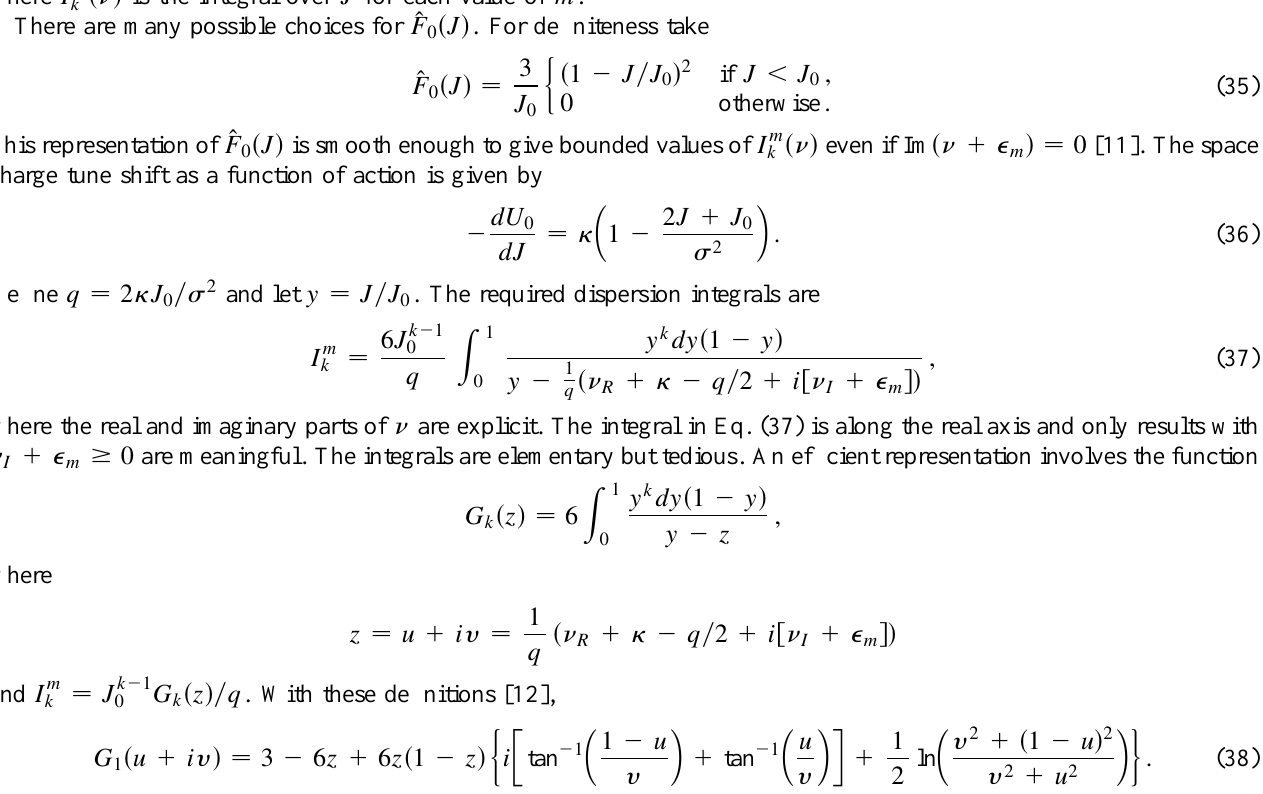
In Fig. 3, distributions from the series p p p (cid:1) 2 s 2 (cid:1)(cid:1)(cid:1) M 1 M (cid:1) j 2 1 (cid:2)(cid:2)(cid:2)(cid:2) ln (cid:1) 1 1 M (cid:2)(cid:6) M e 2 j G for j (cid:1) 1, 2, . . . , M with s G (cid:1) 1 and M (cid:1) 5, 10 are shown. A Gaussian distribution with unit standard de- viation is plotted for comparison. Using Eq. (33) one may show that the density distributions r M (cid:1) D (cid:2) converge uniformly to Gaussians with standard deviation s G as M ! ` .